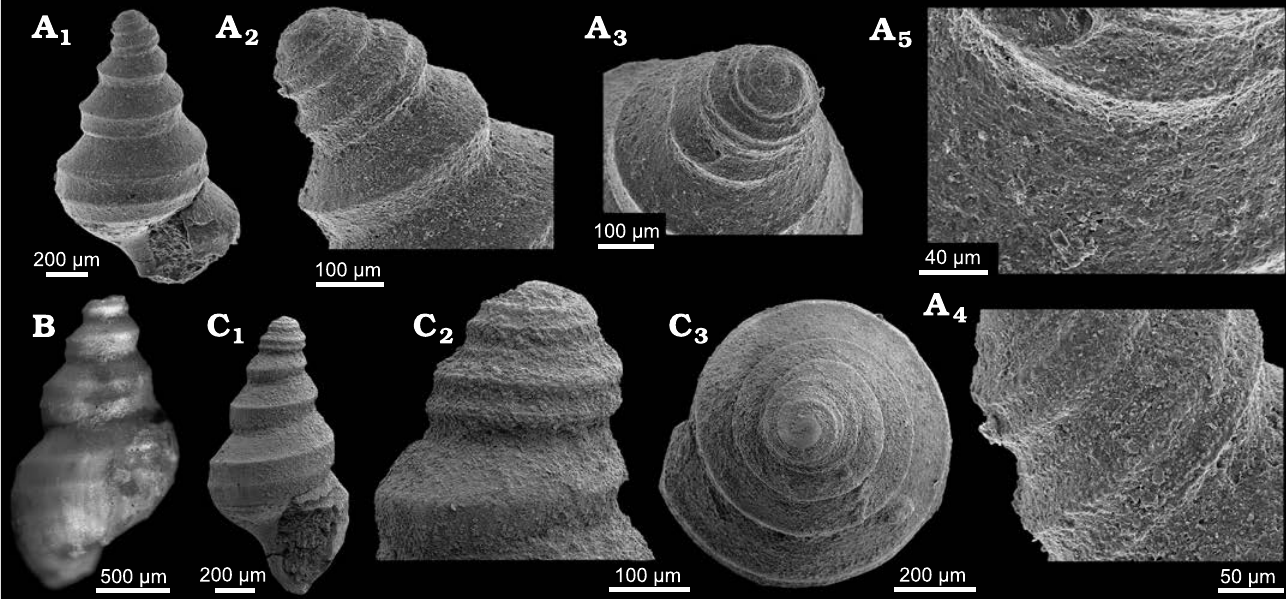
Fig. 15. Caenogastropods Angulatella bizzarinii Nützel and Hausmann sp. nov. from Lago Antorno (A, B) and Misurina Landslide (C), northern Italy, Cassian Formation, Carnian, Upper Triassic. A . Paratype PZO 12826, specimen with preserved protoconch having bicarinate shell, in apertural view (A 1 ); protoconch (A 2 –A 5 ): A 2 , early whorls in lateral view inclucing bicarinate larval shell with axis oblique to teleoconch shell axis; A 3 , early whorls in oblique lateral view showing larval shell terminating at sinusigera; A 4 , close up of larval whorls with carinae ornamented with minute tubercles, in lateral view; A 5 , close up to show tuberculate micro-ornament on teleoconch whorl, upper portion shows sinusigera where larval shell end B . Paratype PZO 12827, relatively large specimen lacking protoconch, in lateral view. C . Holotype, PZO 12701, specimen with preserved protoconch having bicarinate shell, in apertural (C 1 ) and apical (C 3 ) views; C 2 , early whorls including bicarinate larval shell, in lateral